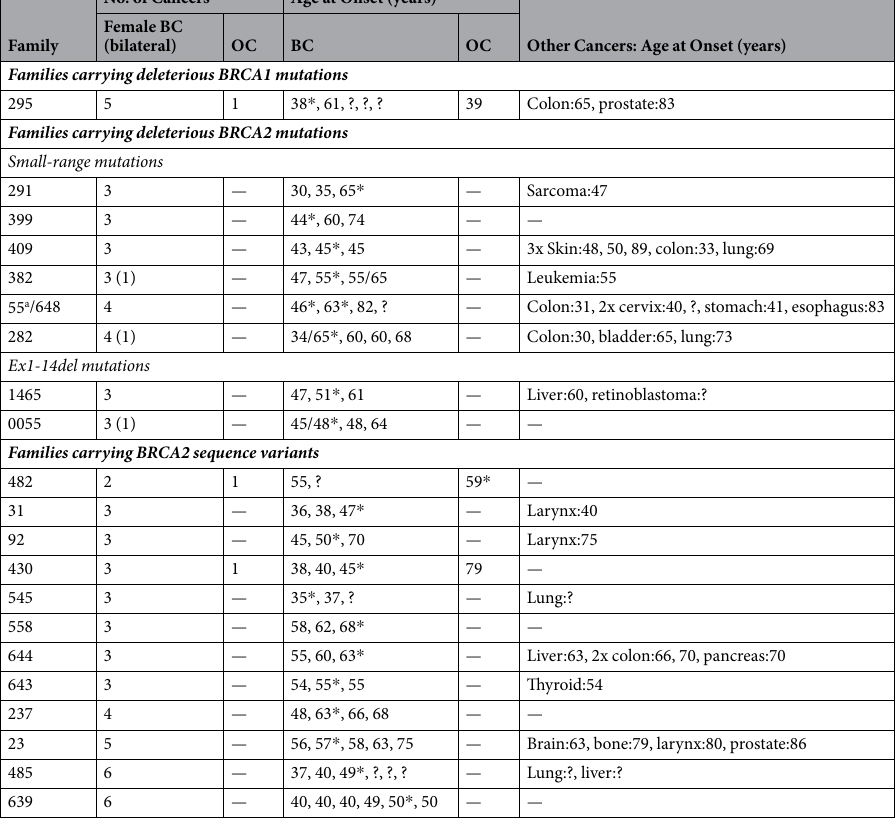
— — Table 3. Characteristics of the Colombian breast/ovarian cancer families harboring BRCA1/2 mutations and variants. * Proband, BC: breast cancer, OC: ovarian cancer. a Case 648 from the Col-BCCC study turned out to be a member of family 55.